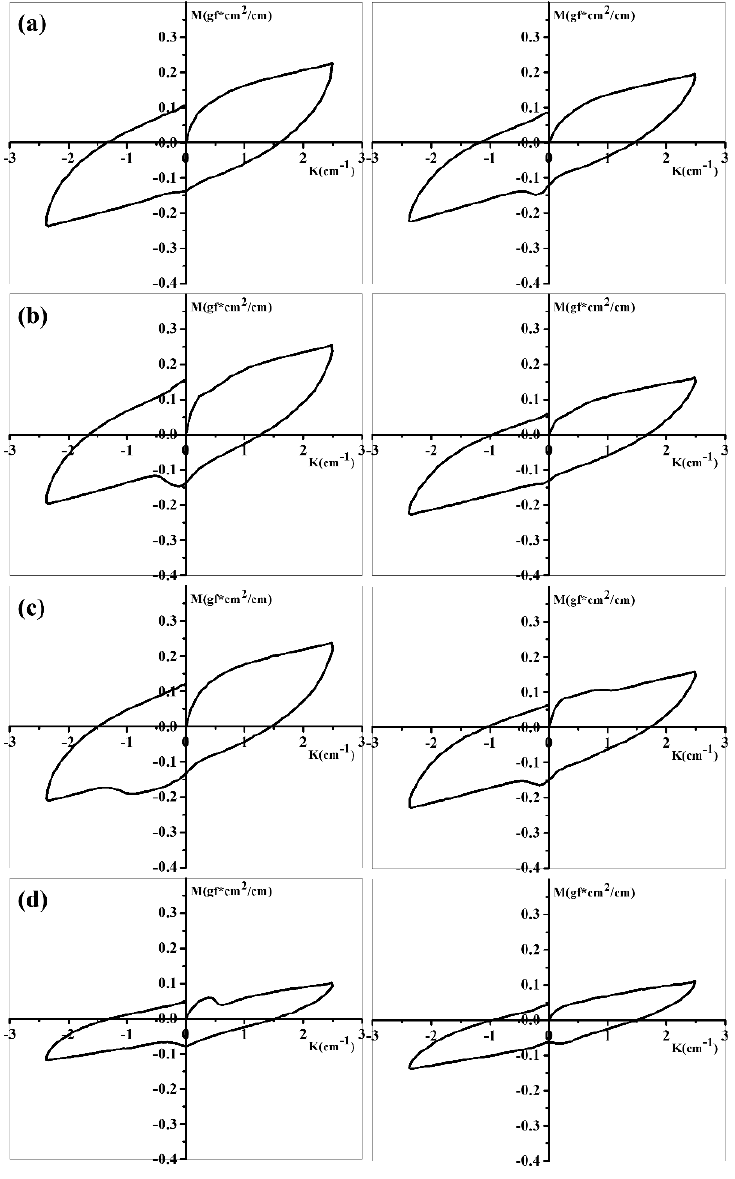
Figure 6. Bending deformation properties of the fabric: ( a ) PA66 in wrap and weft, ( b ) PA66/1%PDMS in wrap and weft, ( c ) PA66/2%PDMS in wrap and weft, ( d ) PA66/3%PDMS in warp and weft.